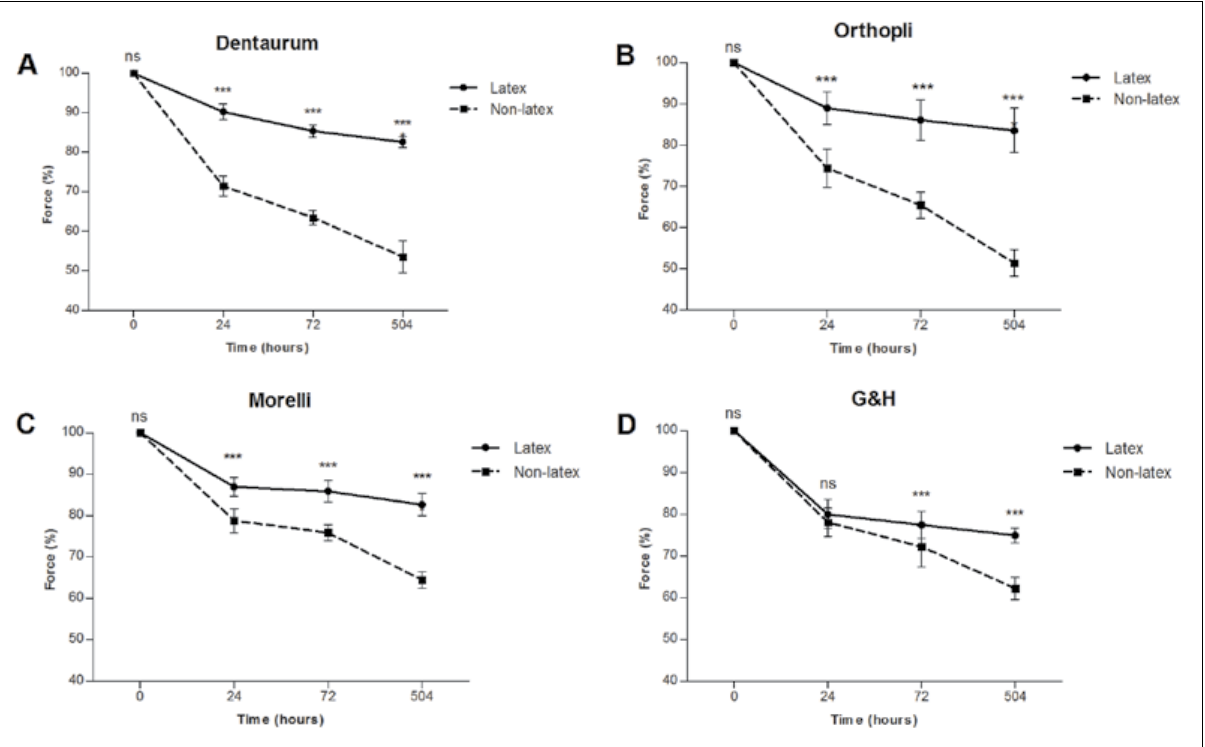
Figure 2. Comparison between the means of force degradation (%) of the elastic latex and non-latex: Dentaurum, Orthopli, Morelli and G&H, in all experimental periods. *** p < 0.001; ns = not